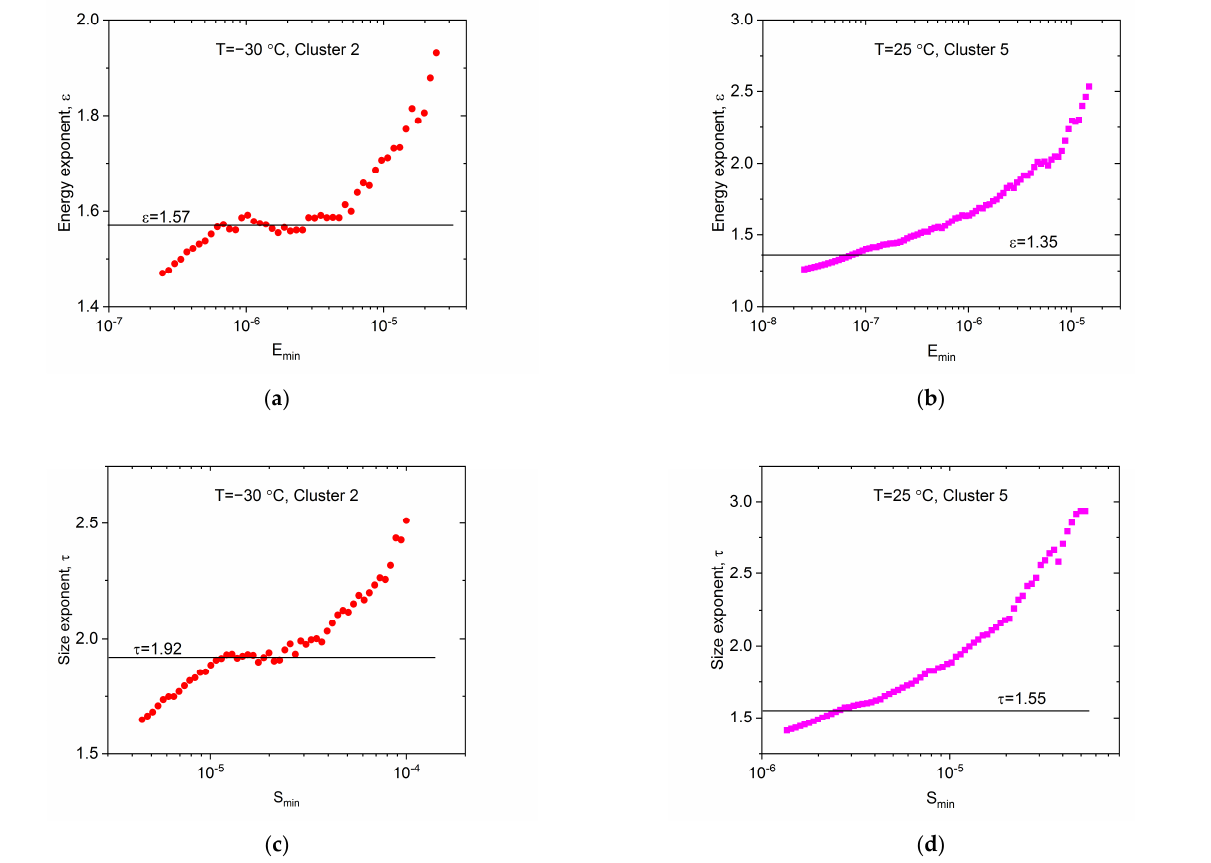
Figure 11. Maximum-Likelihood estimations for the energy ( a , b ) and size ( c , d ) exponents at − 30 °C ( a , c ) as well as 25 °C ( b , d ). For − 30 °C the corresponding exponents are given by the plateaus, while for 25 °C the exponents are approximated because of the exponential damping of the probability density functions.